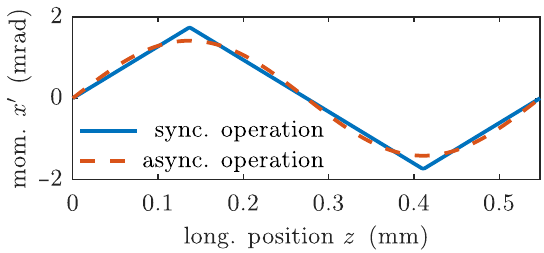
FIG. 4. Transverse momentum modulation of the reference particle in a tilted grating undulator. In a synchronous DLA lattice, the trajectory is a sequence of constant acceleration with alternating sign. The asynchronous DLA lattice imposes a sinusoidal varying